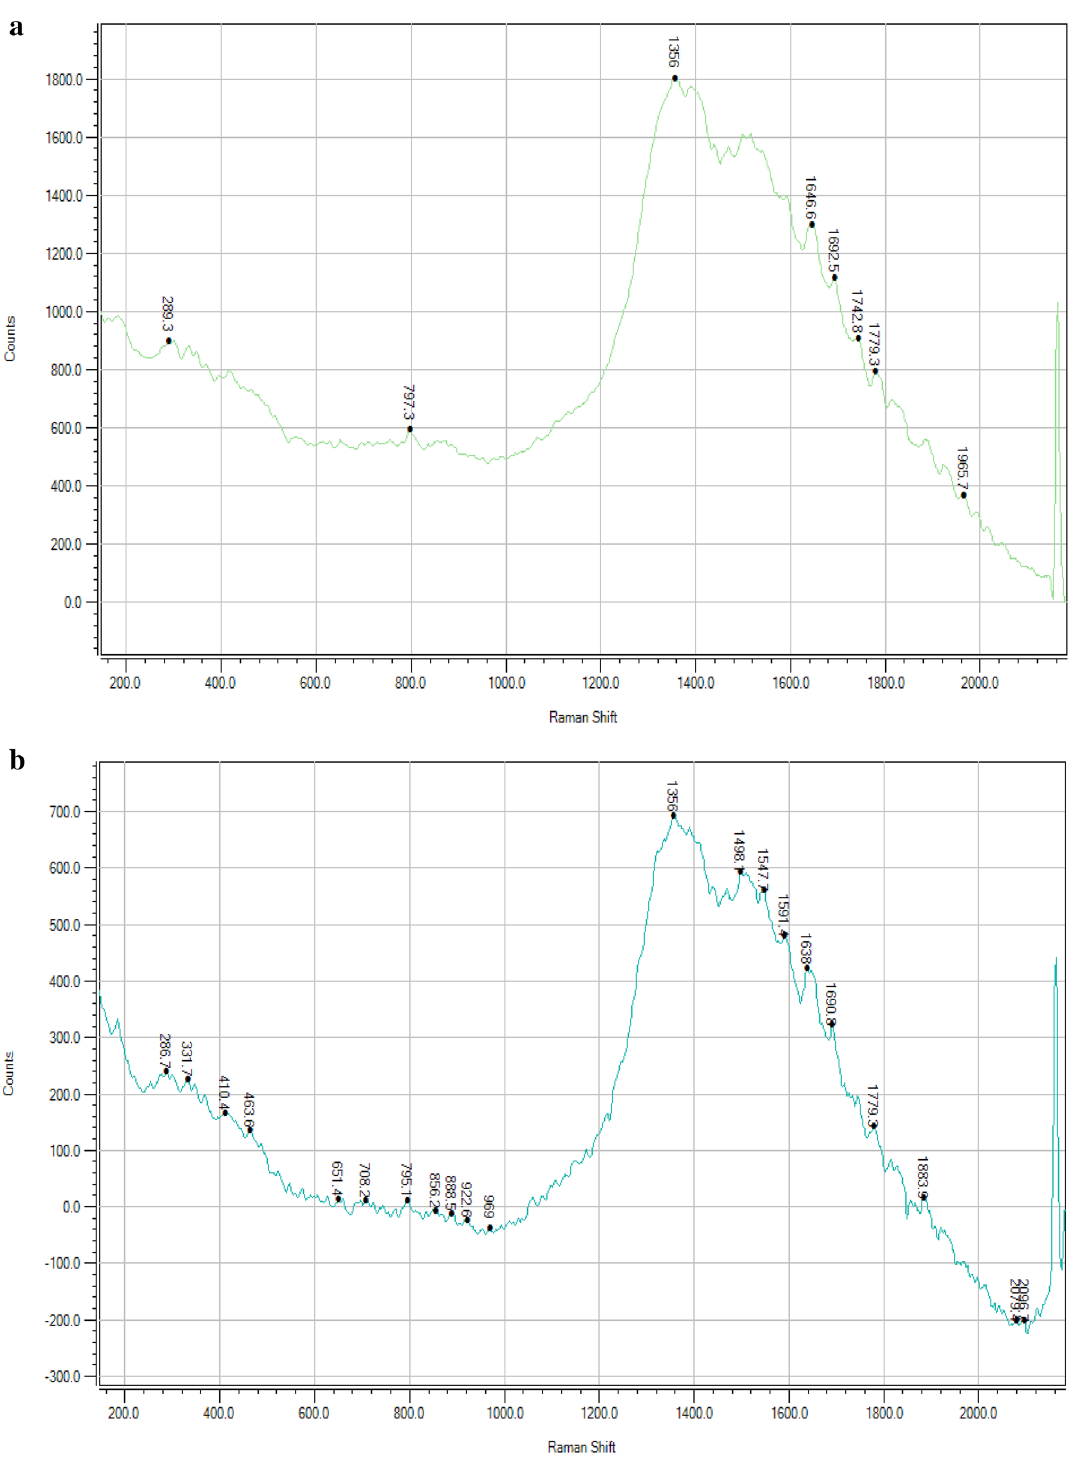
Figure 2. ( a ) Raman spectroscopy of carbon sphere before loading of Zn. ( b ) Raman spectroscopy of carbon sphere after loading of